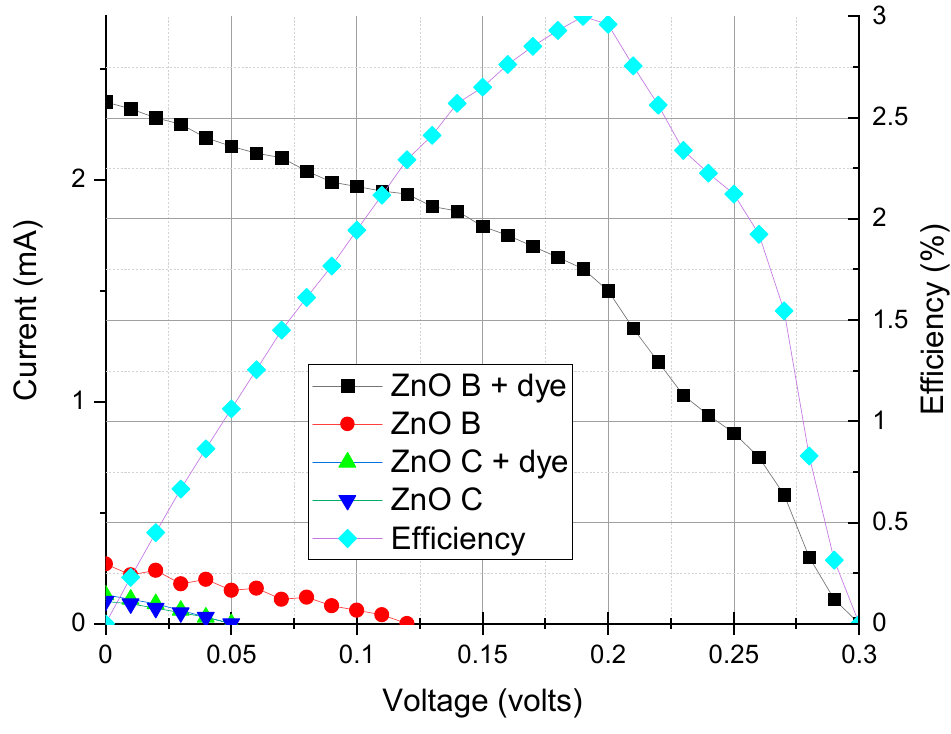
Figure 6. I-V curves for ZnO based DSSC Figure 6. I ‐ V curves for ZnO based DSSC cells.